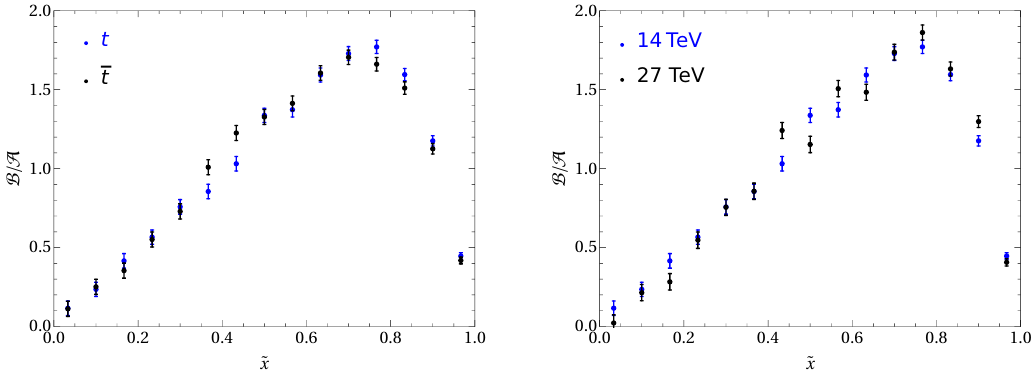
Figure 3 . Comparison of the optimal weight B = A between the pp ! thj and pp ! (cid:22) thj processes extracted from MC simulations (left). The right panel shows the comparison between 14 and 27 TeV proton collision energies for pp ! thj . All plots are obtained using ~ (cid:20) = 1 and with 10 6 MC